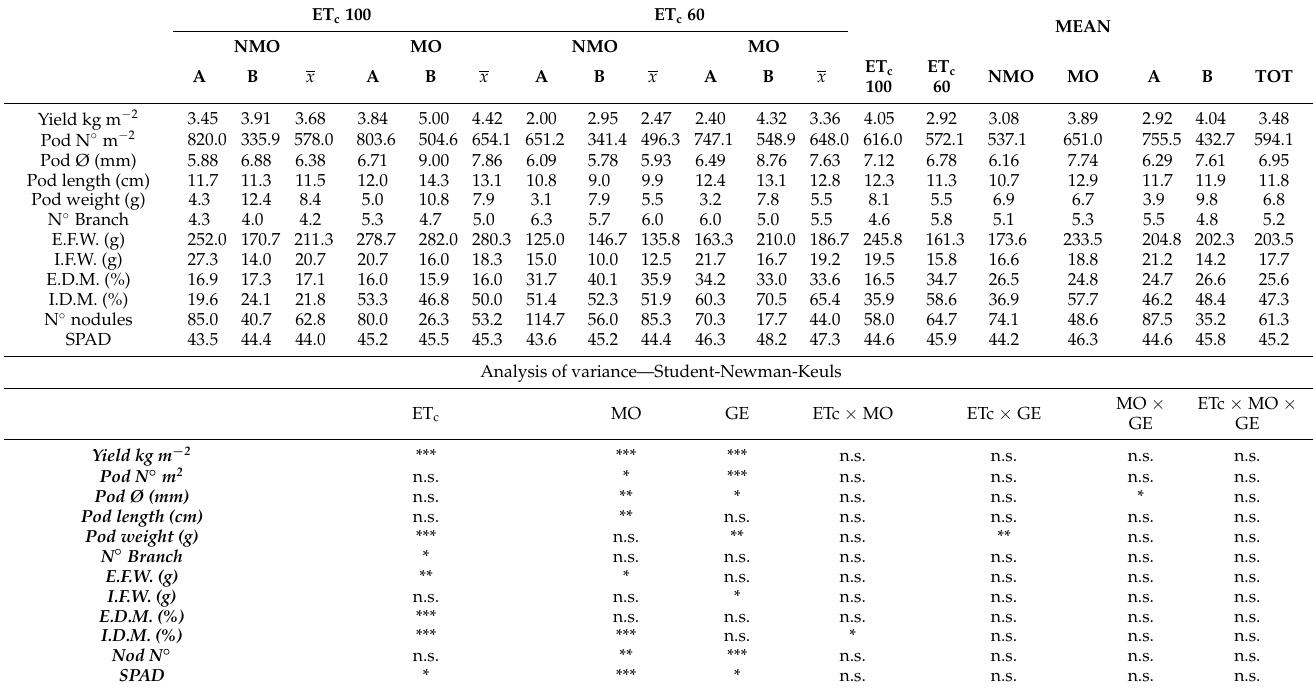
Table 2. Table with all characters analyzed with statistical analysis